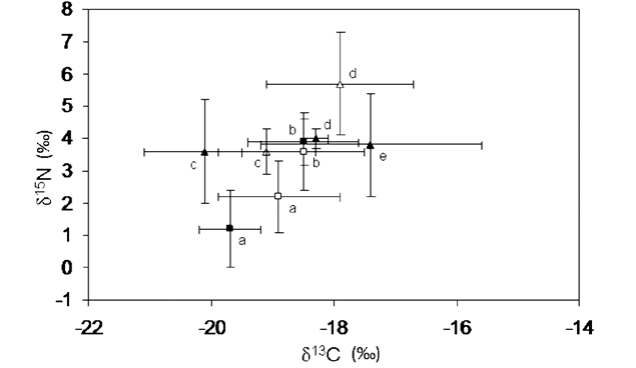
Fig. 2. – Distribution of δ 13 C and δ 15 N values (mean±SD) among population and sex of Maja brachydactyla (triangles) and M. sqi- nado (squares). Sex is denoted by colour (males, black; females, white) and population by letter: a, Ancona; b, Catalonia; c, Ceuta; d, Galicia; e, Morocco.